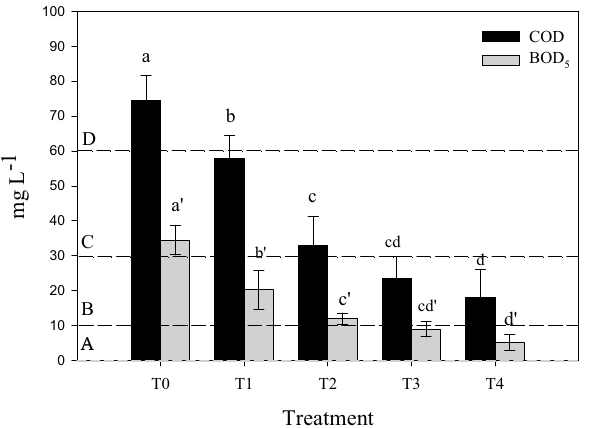
Figure 2. COD and BOD5 in wastewater collected from each treatment unit (the dashed-lines presented the different categories of BOD5 according to the Egyptian Code). T0 (untreated water), T1 (water after sedimentation unit), T2 (water after sand & gravel beds), T3 (water after reed + sand & gravel beds) and T4 (water after biochar + sand & gravel beds). Similar letters indicate no significant variations among